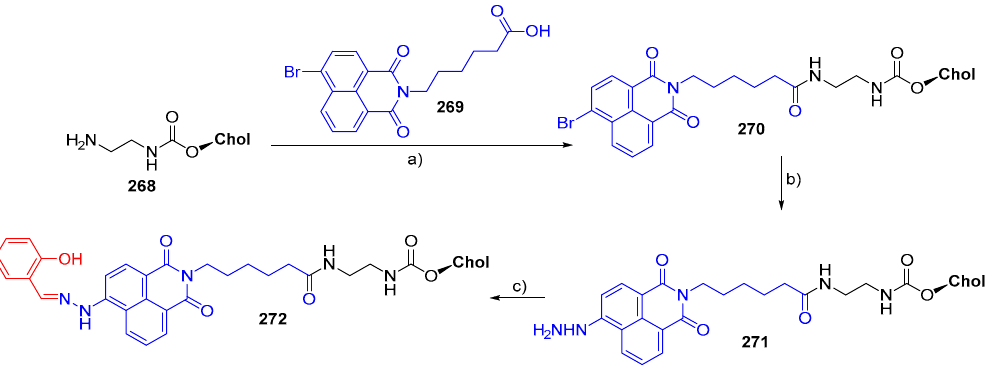
Scheme 66. Synthesis of cholesterol naphthalimide-based gelators. Reagents and conditions: a ) EDAC/BtOH; b) NH 2 NH 2 ∙ H 2 O, CuCl, EtOH, reflux, 3 days; c ) salicylaldehyde, EtOH, reflux, 24 h.